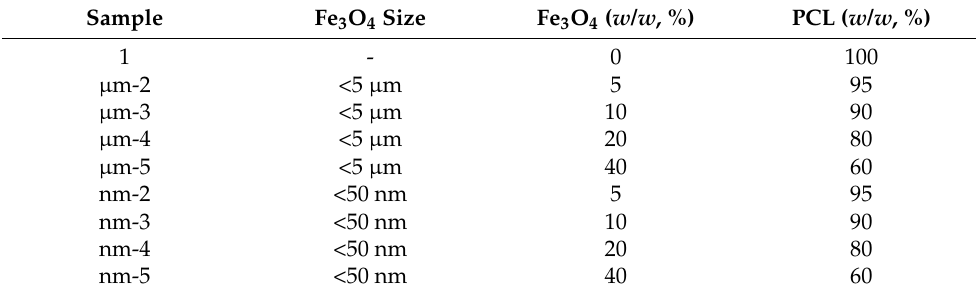
Table 1. Preparations of Fe 3 O 4 /PCL scaffolds with different ratios of